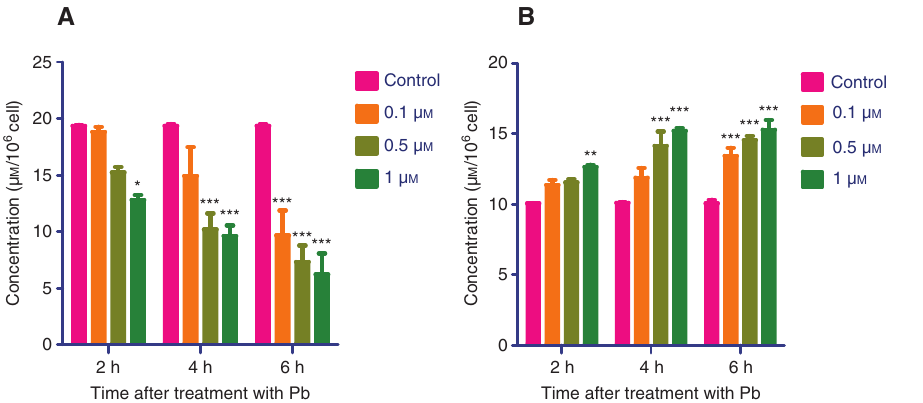
Figure 6: The effect of Pb acetate on glutathione (GSH) and GSSG. GSH and GSSG measured in accordance with Hissin and Hilf methods 2 h, 4 h and 6 h after treatment with